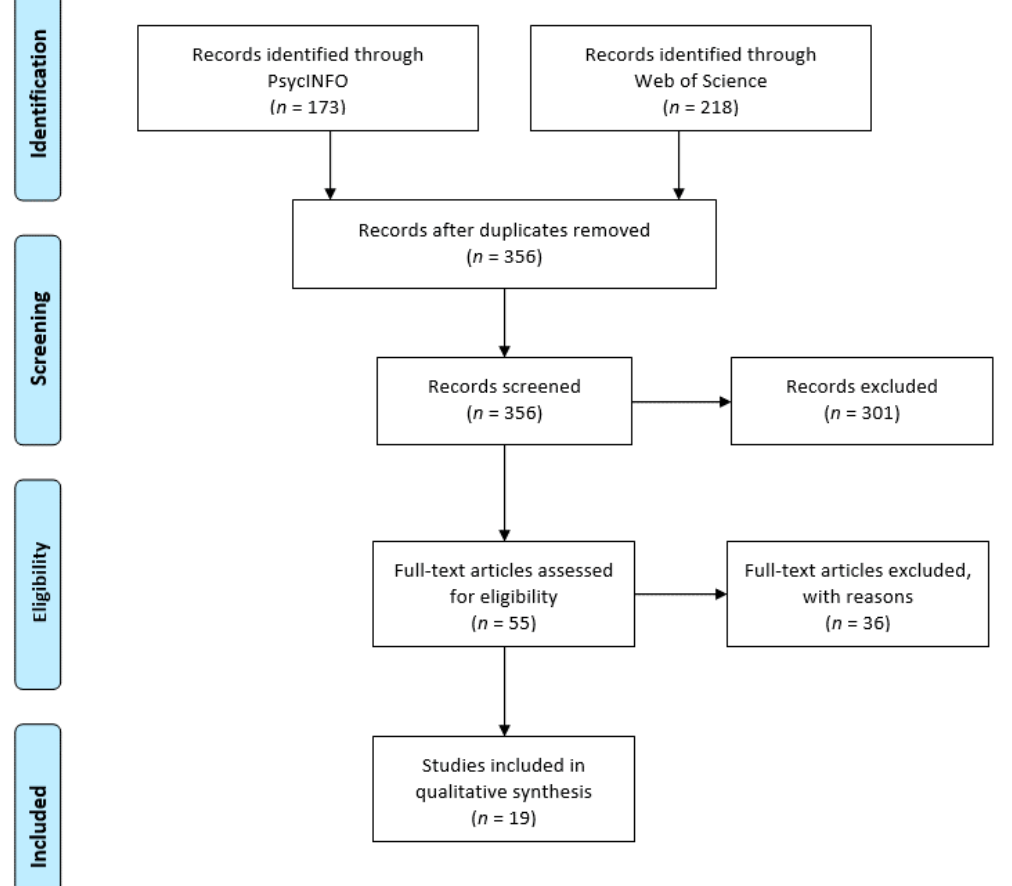
Figure 1. PRISMA Flow diagram of study selection processes.